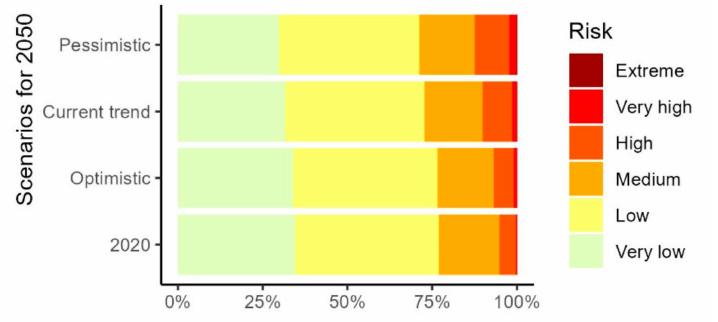
Figure 7. Proportion of projected hydropower projects in different risk classes for risk of water